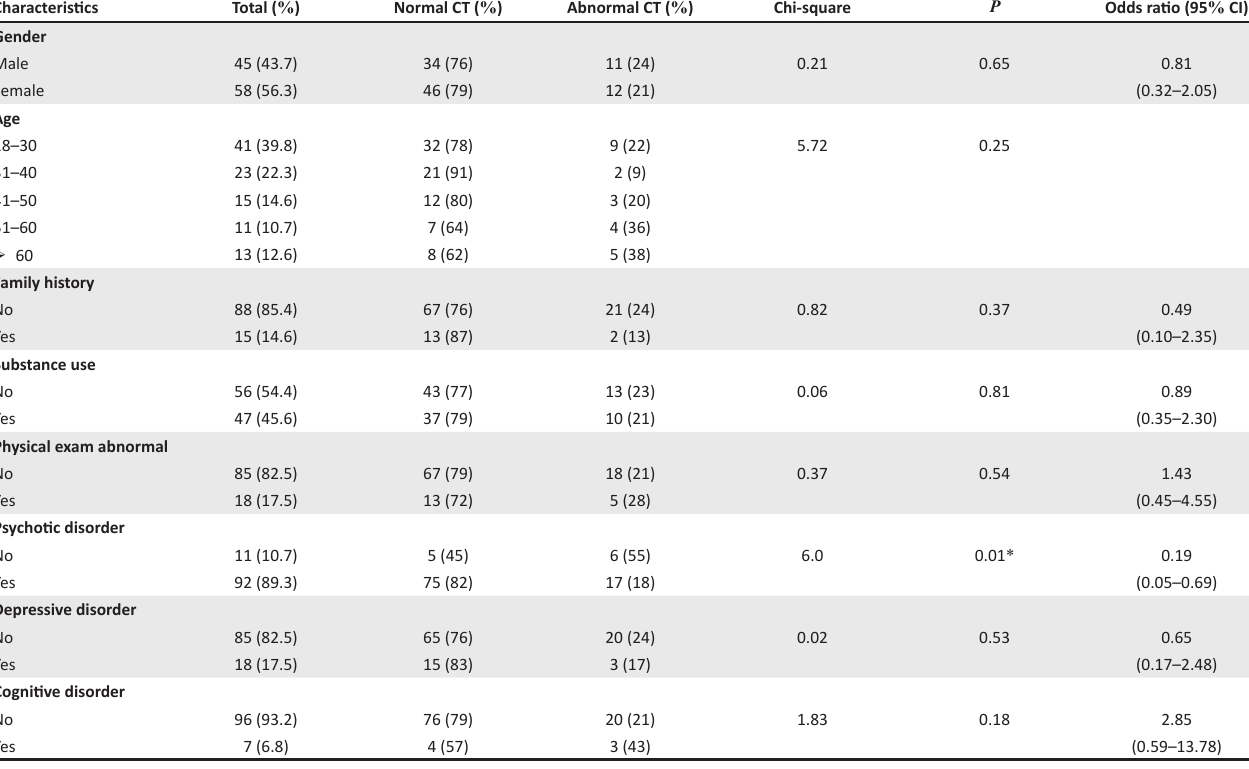
TABLE 1: Correlations of demographic and clinical factors with normal versus abnormal computerised tomography scan results. Characteristics